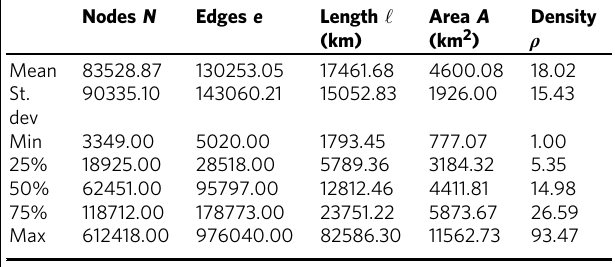
Table 1 Aggregate statistics for the 97 street